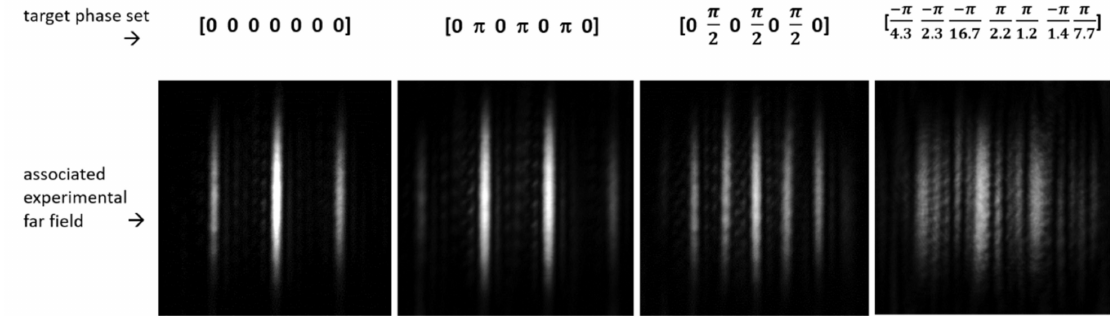
Figure 9. Examples of experimental far field patterns of phase-locked fiber laser output and their associated target phase sets.